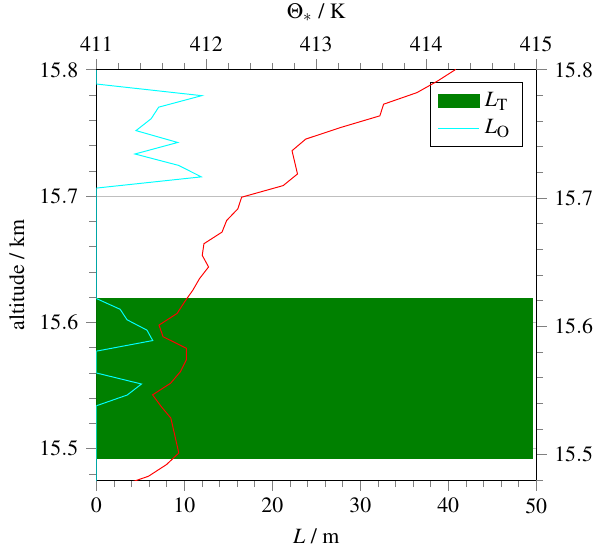
Figure 4. Zoomed plot of Thorpe (green) and Ozmidov (cyan) scales for the BEXUS 12 flight. The potential temperature is plotted in